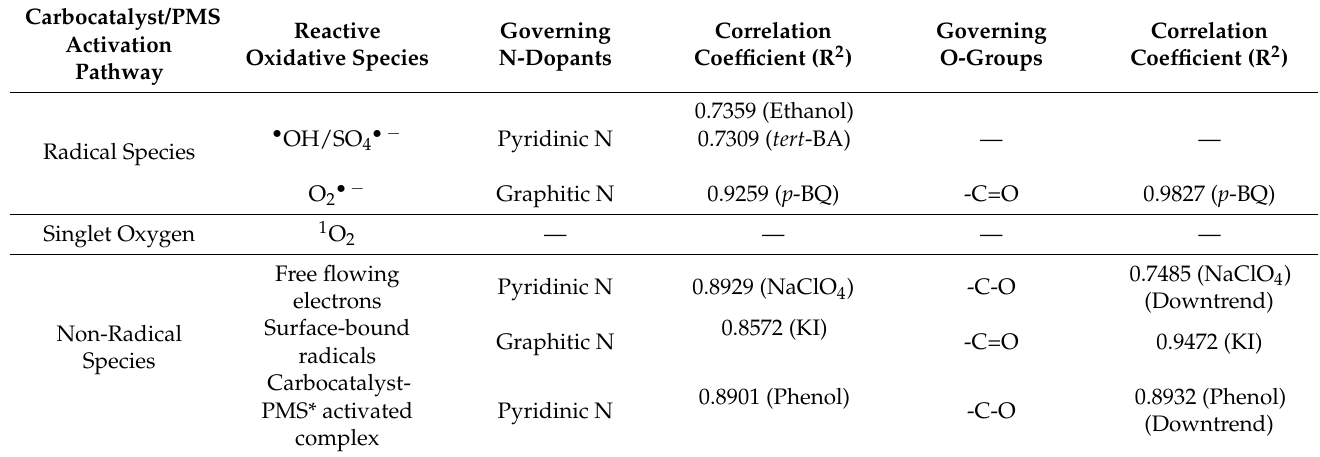
Table 3. Role of N-dopants and oxygen functional groups on carbocatalyst/PMS activation